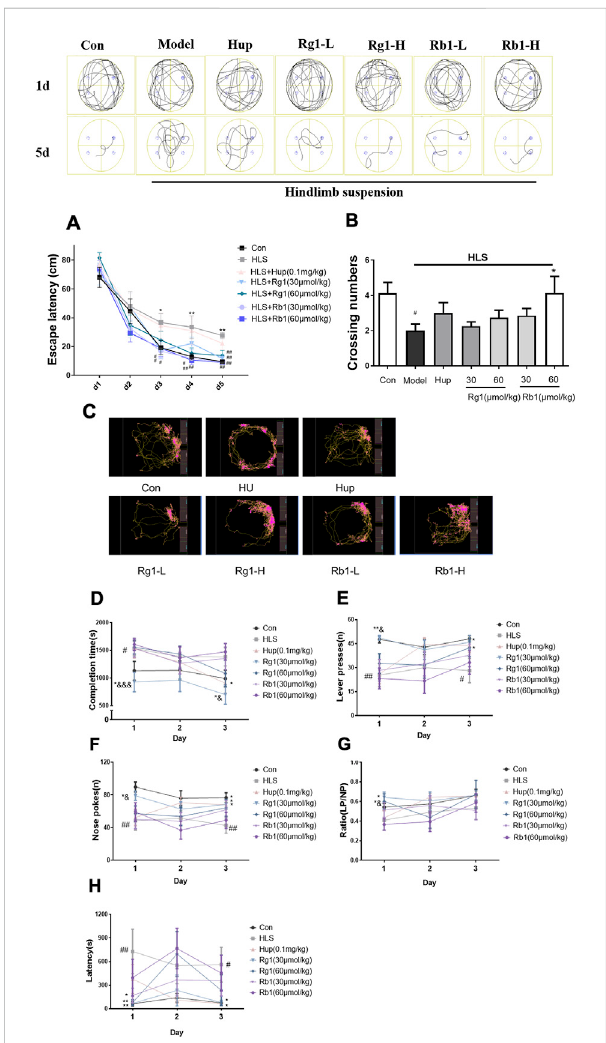
FIGURE 2 Ginsenosides Rg1 and Rb1 ameliorate cognitive dysfunction measuredbybehavioral testsinhindlimbsuspension(HLS)modelrats. (A-B) The Morris water maze testwas used to measure escape latency and frequency of crossing the platform over 5 days. (C – H) Representation of moving path, Completion time, Lever presses (LPs), Nose-pokes (NPs), LP/NP ratio, and the latency on the acquisition of operant conditioning re fl exes (lever-pressing) in the ROCR test. The data represent mean ± SEM; N = 10 rats per group. # p < 0.05, ## p < 0.01, signi fi cantly different from control; * p < 0.05, ** p < 0.01, signi fi cantly different from HLS group. & p < 0.05, && p < 0.01, &&& p < 0.001, signi fi cantly different from Rb1